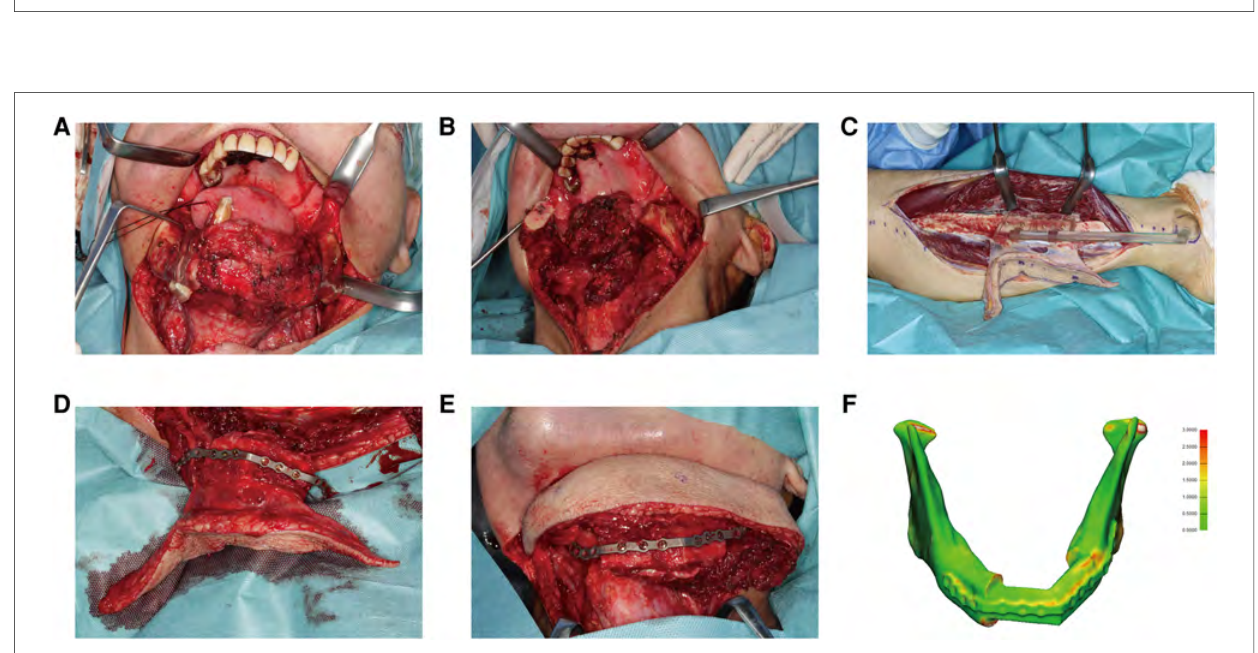
FIGURE 6 A 65-year-old female with osteoradionecrosis of left mandible underwent PSSPs-enhanced CAMR. ( A ) After exposure, left mandible showed eroded bone surface and pathologic fracture. Cutting guides were mounted to guide mandibular resection. ( B ) The resected bone specimen was shown. ( C ) The defect site was shown, and cutting guides were fi xed in situ by screws. Resection margins were accurately located by the presence of bleeding bone. ( D ) The left fi bular osteo-cutaneous fl ap was harvested with the cutting guide. ( E ) The fi bula was fi xed to PSSP using predrilled screw holes. ( F ) The “ fi bula-plate ” was transferred to the defect site and fi xed according to predrilled screw holes. ( G ) The intraoral skin island fl ap was viable. ( H ). The extraoral skin island fl ap was viable. The neo-mandible contour is satisfying.